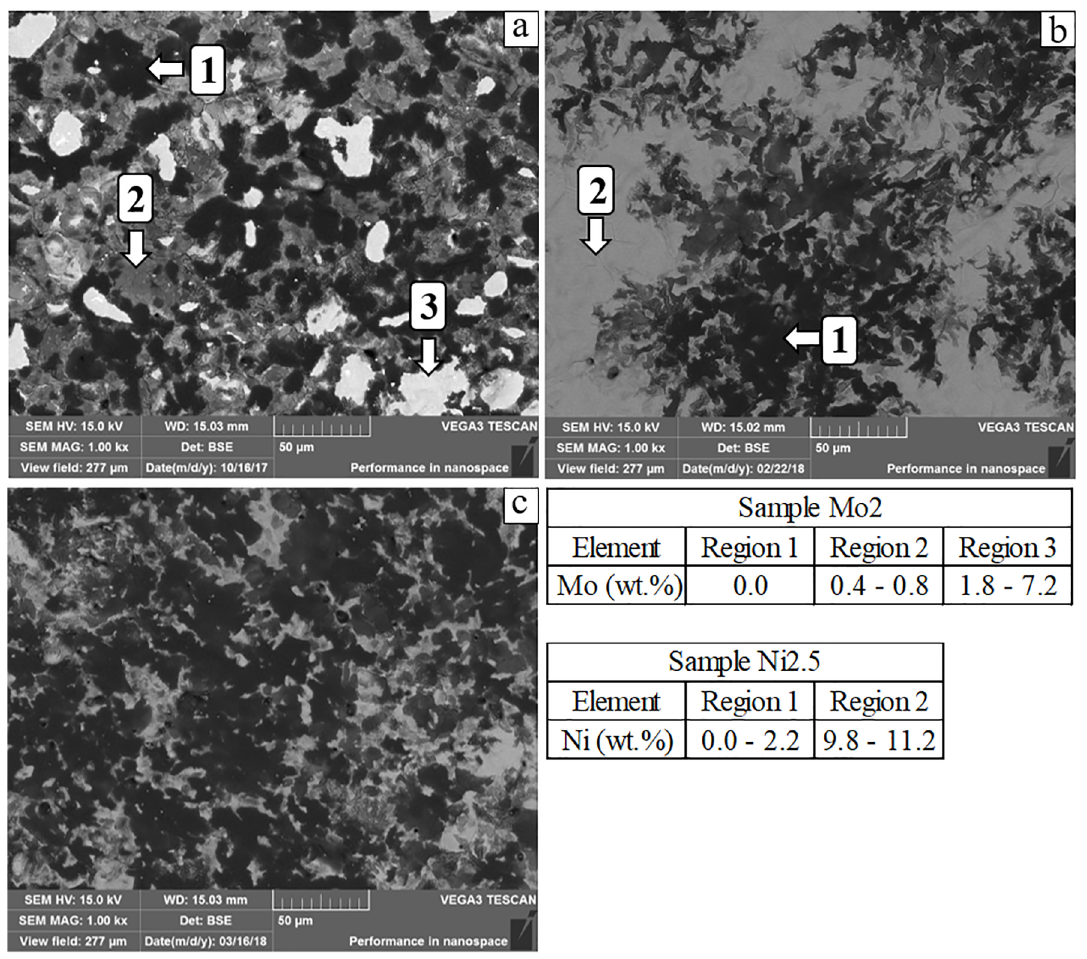
Figure 2. SEM image of surface of the samples and EDX results: (a) in sample Mo2 there was no coating of lubricant stocks with molybdenum, (b) a partial coating of lubricant stocks was observed in sample Ni2.5, enriched with nickel and (c) sample S1, sintered